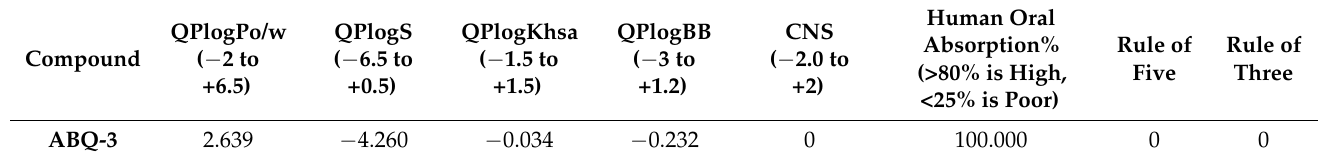
Table 5. Predicted pharmocokinetic properties of ABQ-3